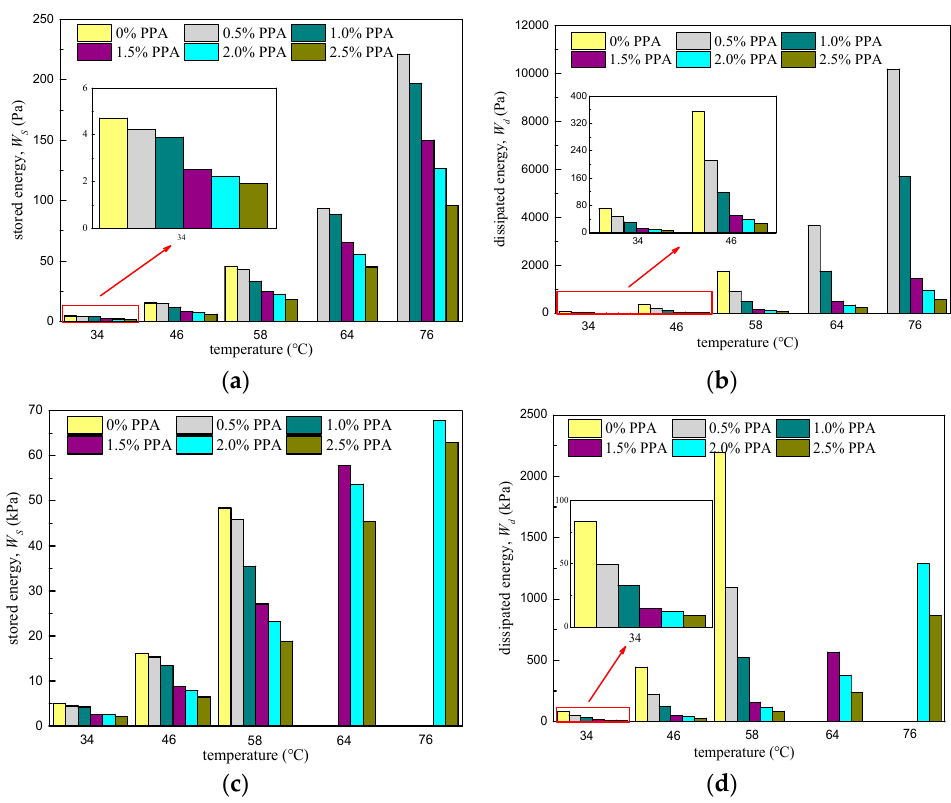
Figure 13. Calculation results of 𝑊 (cid:3046) (𝑡) and 𝑊 (cid:3031) (𝑡): ( a ) Stored energy 𝑊 (cid:3046) (𝑡) at 0.1 kPa; ( b ) dissi- pated energy 𝑊 (cid:3031) (𝑡) at 0.1 kPa; ( c ) stored energy 𝑊 (cid:3046) (𝑡) at 3.2 kPa; ( d ) dissipated energy 𝑊 (cid:3031) (𝑡) at energy W d ( t ) at 0.1 kPa; ( c ) stored energy W s ( t ) at 3.2 kPa; ( d ) dissipated energy W d ( t ) at 3.2 kPa. 3.2 kPa.